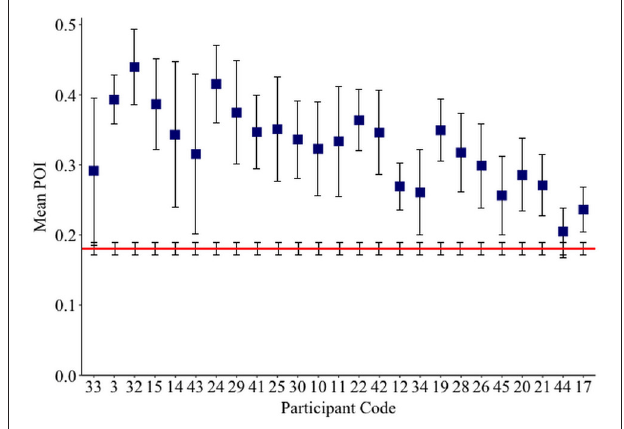
FIGURE 2 | Mean neologism Phonological Overlap Index (POI) score per Jargon individual (squares), and the mean chance POI estimate (red line). Error bars show 95% confidence intervals.